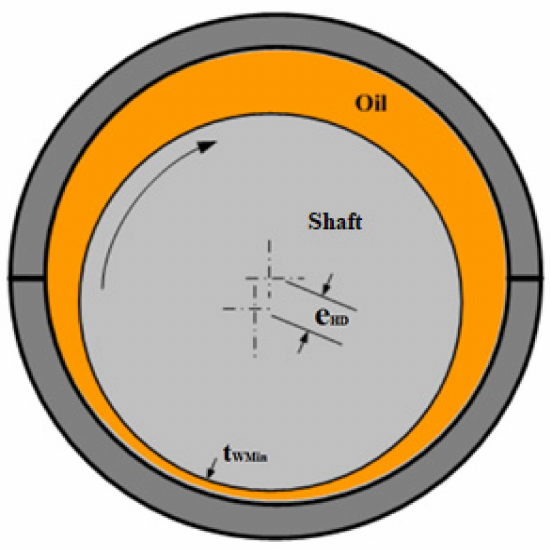
Figure 1. Hydrodynamic eccentricity in the journal bearing of the